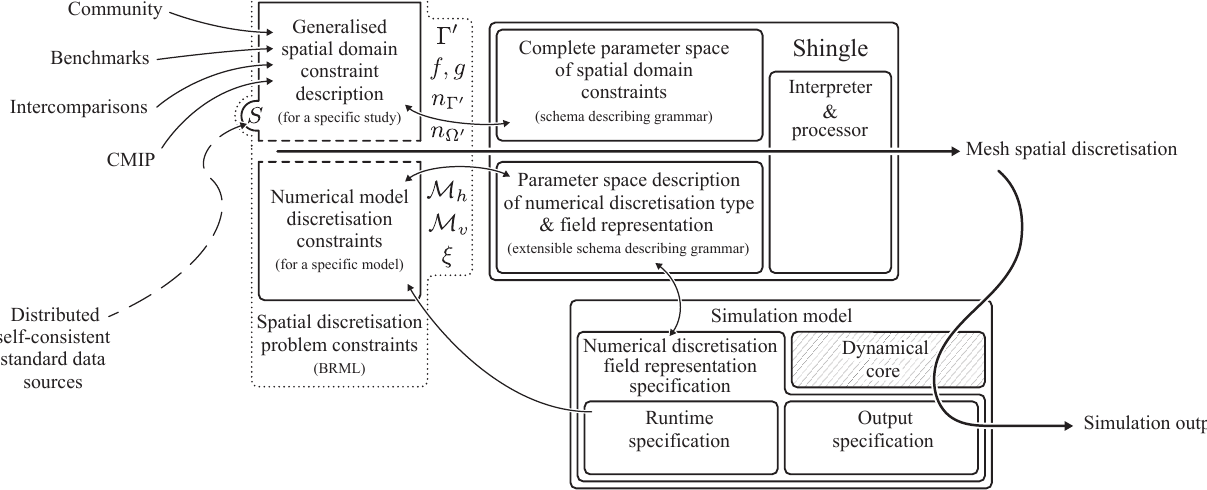
Figure 10. Framework for generalised spatial domain discretisation for geophysical model simulations. A formal spatial domain constraint description (a model-independent grouping of high-level directives describing key geospatial boundaries and features, the required spatial resolution, and source datasets) for a specific study (e.g. the geography to include in a CMIP intercomparison study) is joined with specific constraints from a simulation model, depending on its internal numerical discretisations and field representations (e.g. following Gridspec Balaji et al., 2007, or a UFL description: Alnæs et al., 2014). These constraints are used by the Shingle interpreter to produce, in a robust, au- tomated, repeatable process, a model-specific mesh spatial discretisation. Moreover, the latter description is further used to specify numerical simulation output representation (as CMIP uses